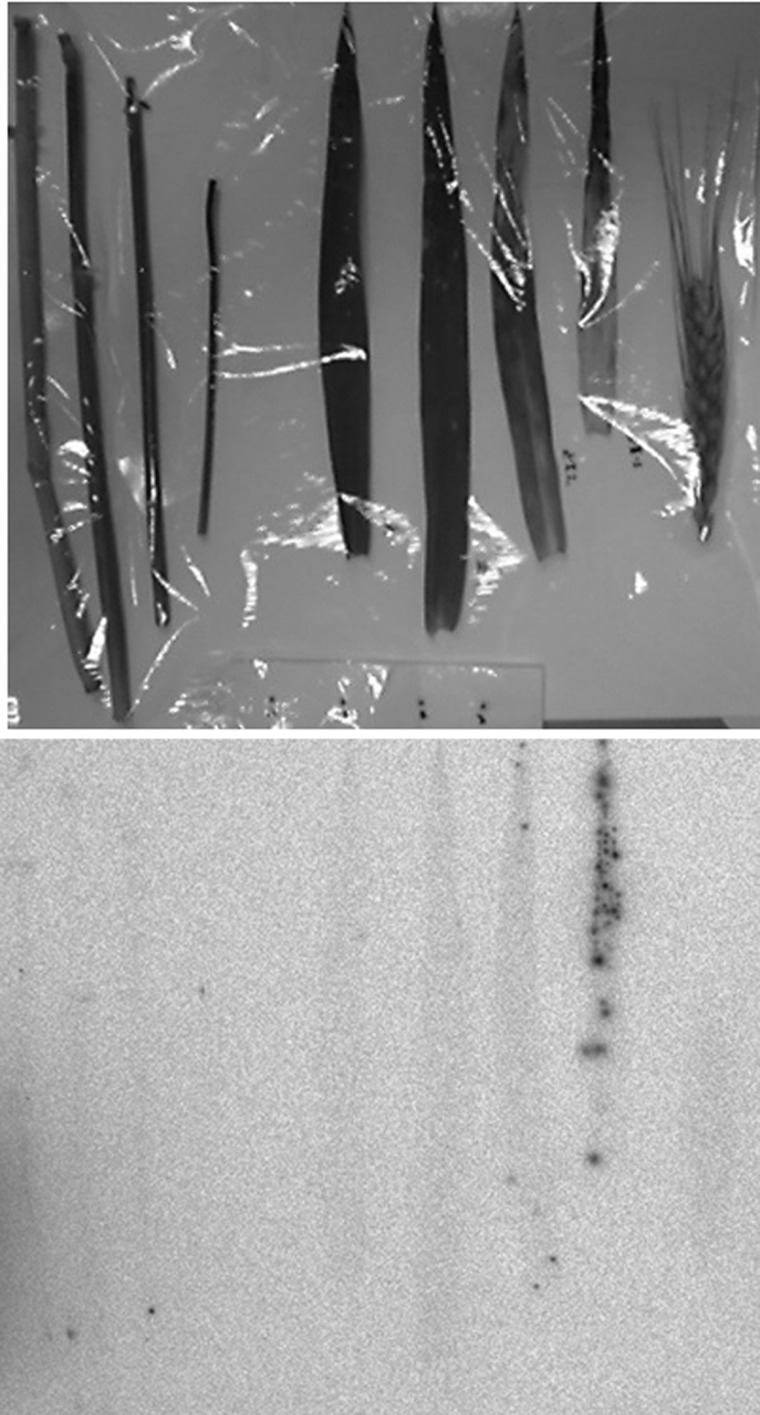
Contamination of wheat [1,2]. Two months after the accident, the wheat plant with the developed ear was harvested and a radioactivity image was taken on an imaging plate. Upper figure: photo of the wheat plant; lower figure: autoradiograph of the sample in the upper figure. Most of the radioactivity was found in an old leaf that was exposed to the air at the time of the accident; the radioactivity hardly appeared in the other tissues. This result suggested that once radioactive cesium had been adsorbed on the leaf surface, it hardly moved and was not incorporated within the leaf for transfer to the other developing tissues (K. Tanoi et al.).